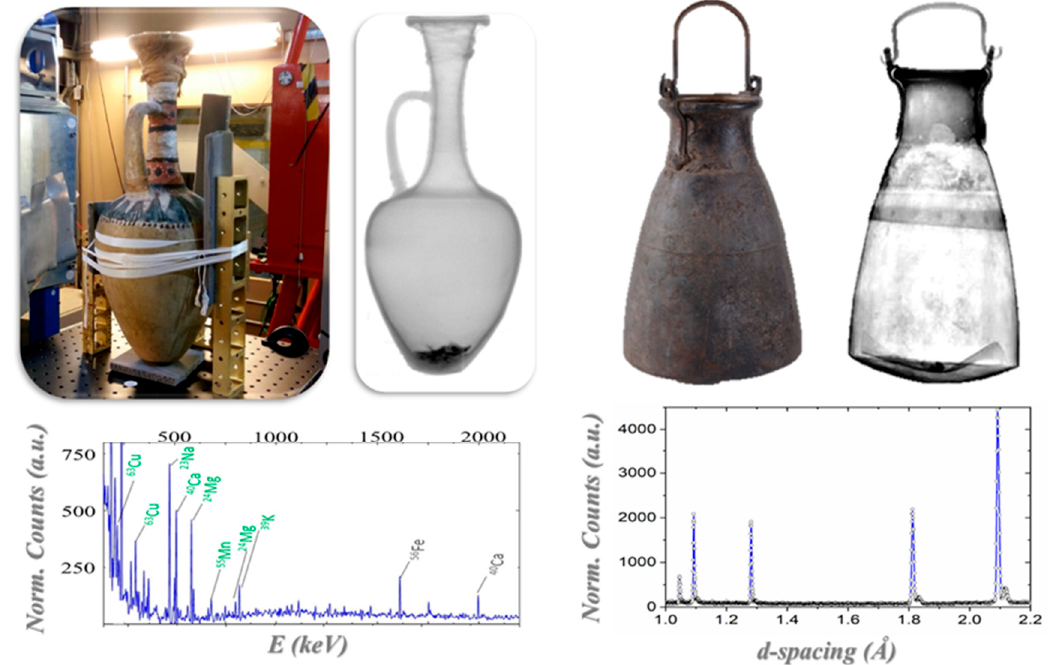
Figure 6. Egyptian objects from the Kha and Merit grave goods. Left: sealed ceramic vase investigated through neutron techniques, neutron radiography, and PGAA plot with the labels of the detected isotopes [32,79]; Right: Egyptian metallic vase (situla), neutron radiography and one of the acquired diffraction patterns [25].